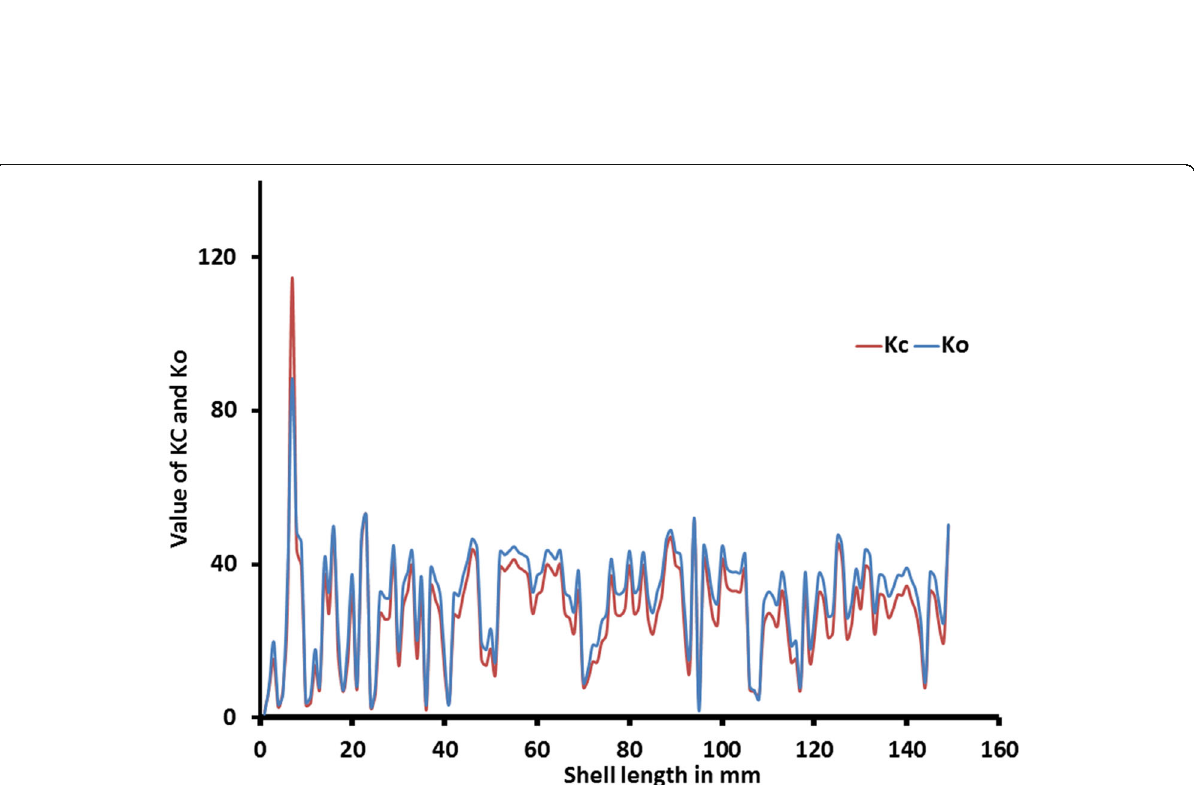
Fig. 5 Relationship between shell length and calculated weight ( K C ) and observed weight ( K O